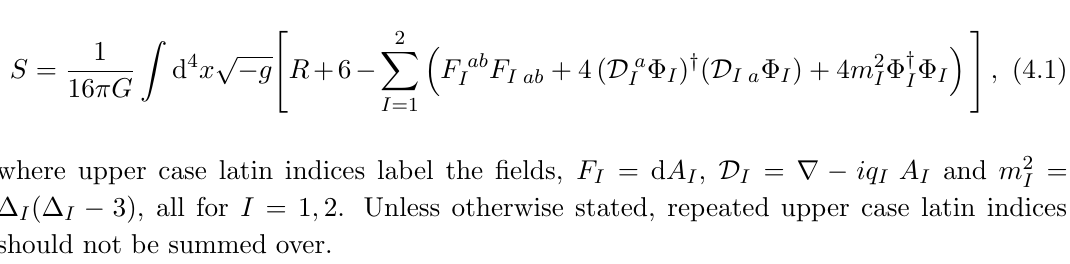
Figure 6 . The blue solid line indicates the onset of solutions with (cid:8) 6 = 0, and the red dots the approximate location of singular solutions. This plot was generated with (cid:11) = hold for (cid:11) (cid:21)